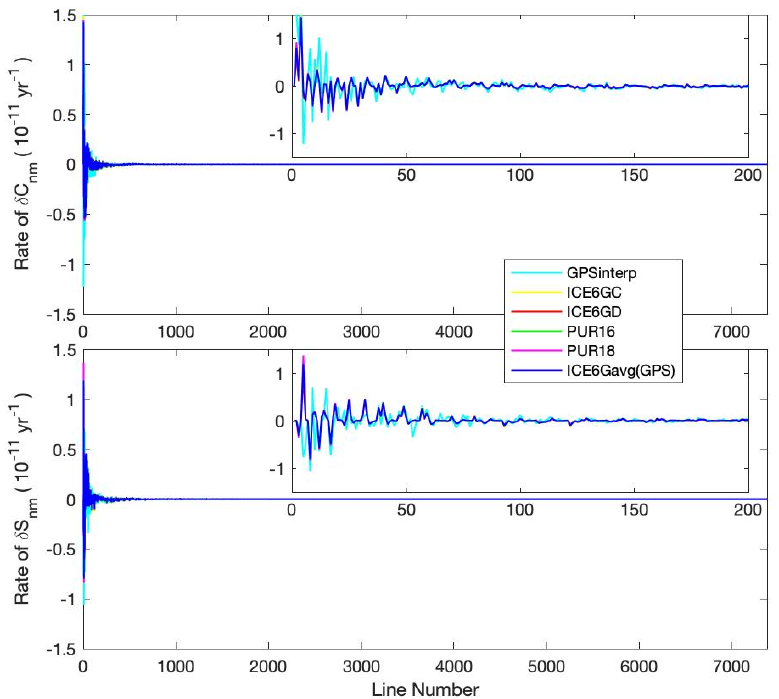
Figure 12. Rates of Stokes coefficients due to GIA as derived from ICE6GC/D, PUR16/18, GPSinterp, and ICE6Gavg (GPS). The coefficients for line number ≤ 200 are displayed in small boxes to show more details.